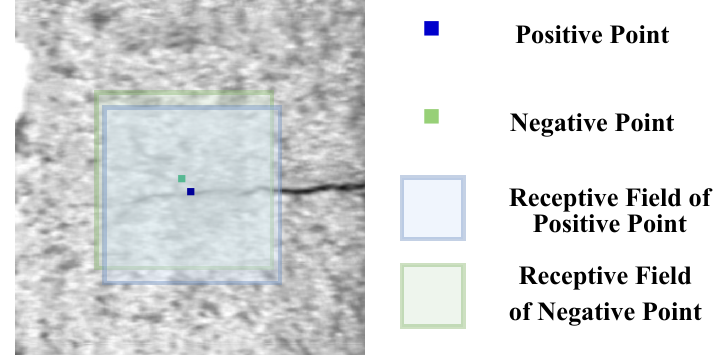
Figure 3. A graphical illustration of label confusion at boundary points. For two nearby points (blue and green solid dots) at the boundary of the defect, the receptive field and the perceived image features for the two points are very similar, but they are trained to make different